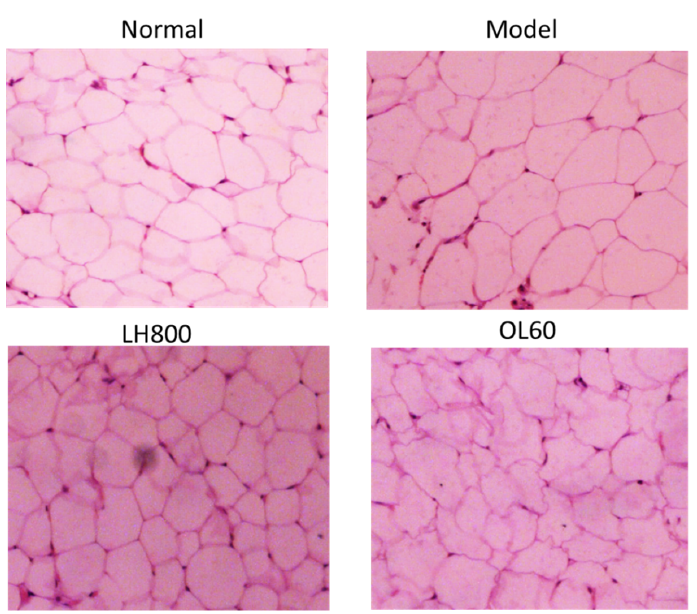
Figure 3. Effects of LH on the size of abdominal adipocytes of mice. Hematoxylin and eosin (H&E) staining (100× magnification). Normal, normal group; model, high-fat control group. LH800: group orally treated with LH at dosage of 800 mg/kg/day; OL60: group orally treated with OL at 60 mg/kg/day (n = 10).